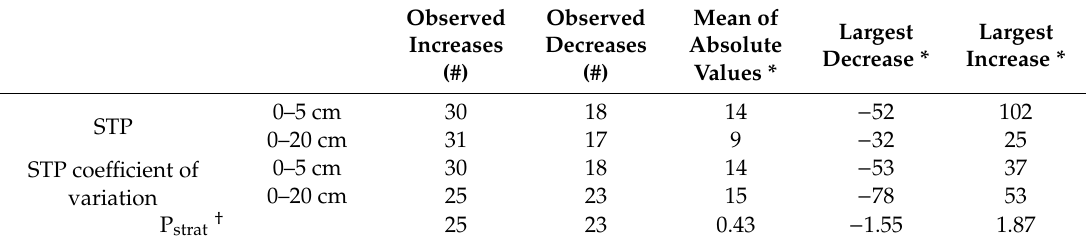
Table 2. Summary of changes in soil test P (STP), STP coe ffi cient of variation, and P stratification ratio (P strat ) between subsequent soil sampling events in individual